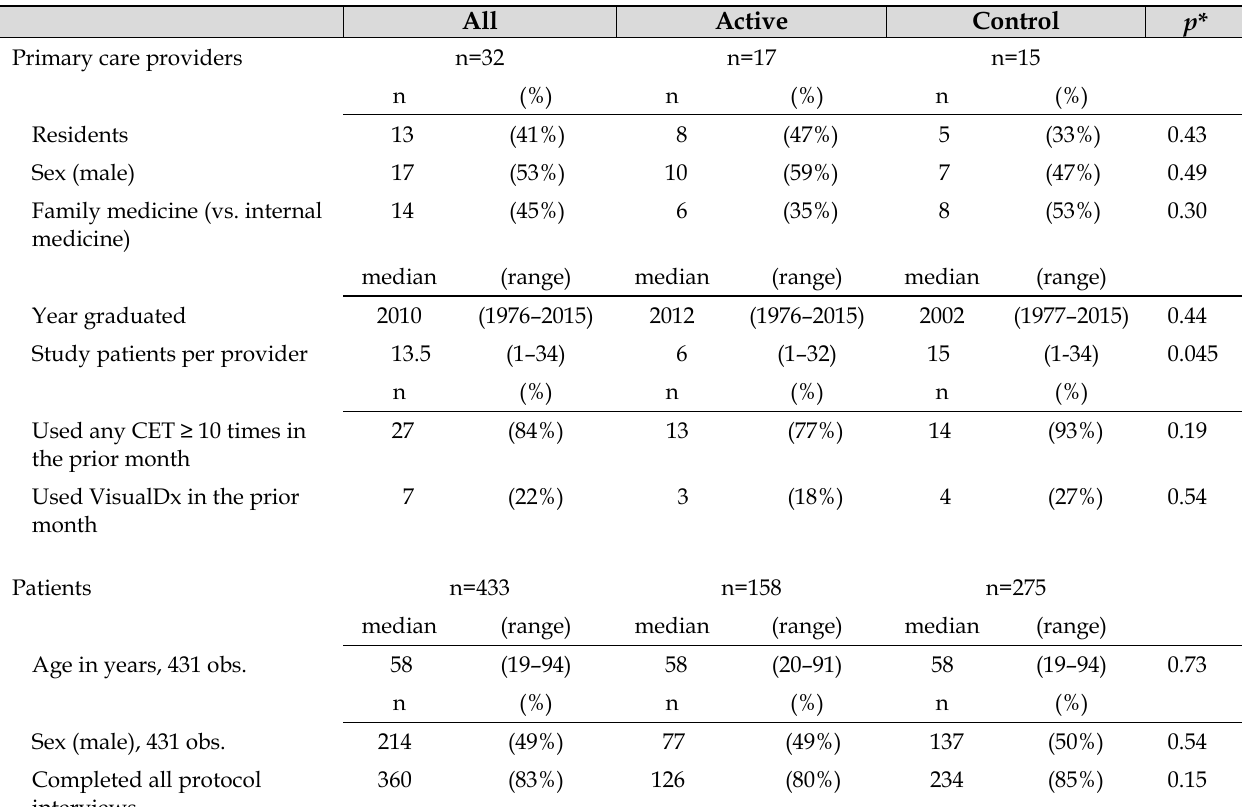
Table 1 Characteristics of primary care providers and patients All Active Control